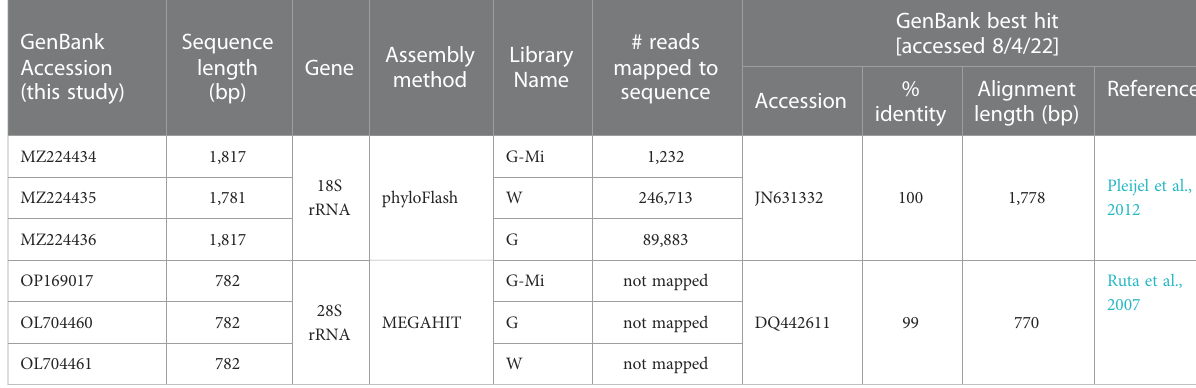
TABLE 1 Taxonomic assignments to the polychaete S. methanicola based on nuclear 18S rRNA and 28S rRNA gene annotations recovered from the three metagenomic libraries.